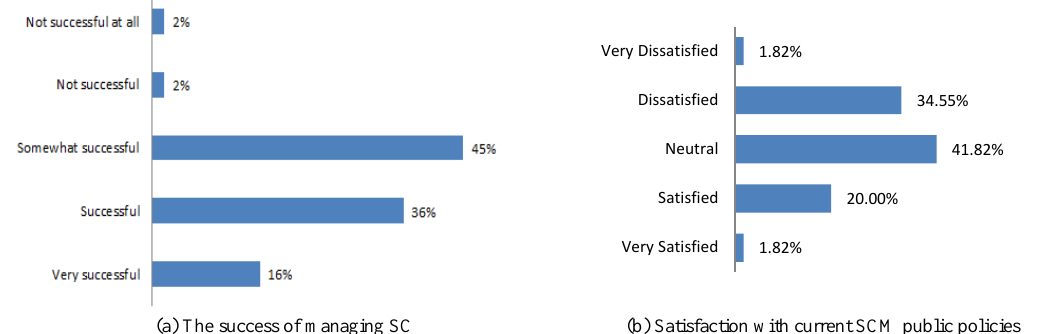
Figure 5. SCM activities and public policies performance